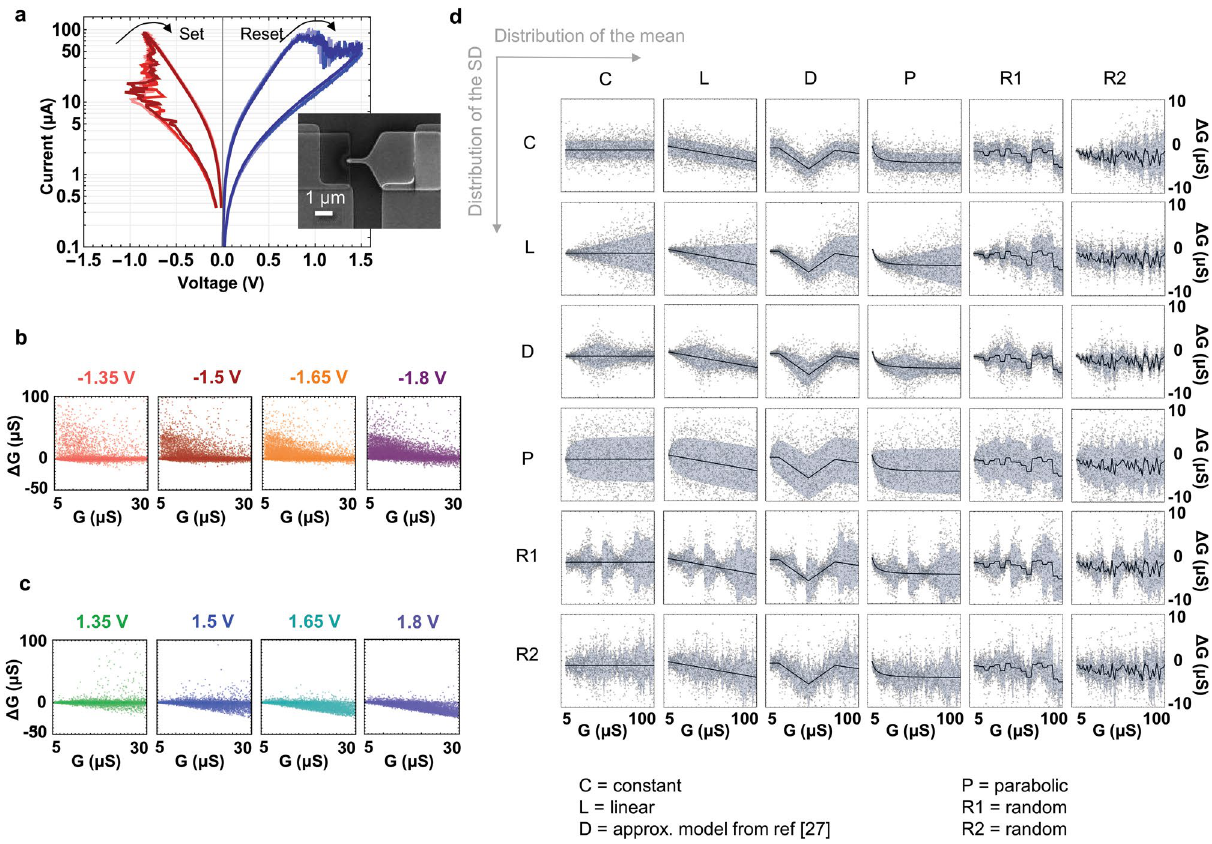
Figure 2. Device data. ( a ) RRAM used for experimental data gathering with current–voltage characteristics and SEM image; and ΔG vs. G data at different pulse amplitudes for ( b ) set and ( c ) reset. ( d ) Synthetic device data encompassing a wide range of distributions of mean and SD from constant to